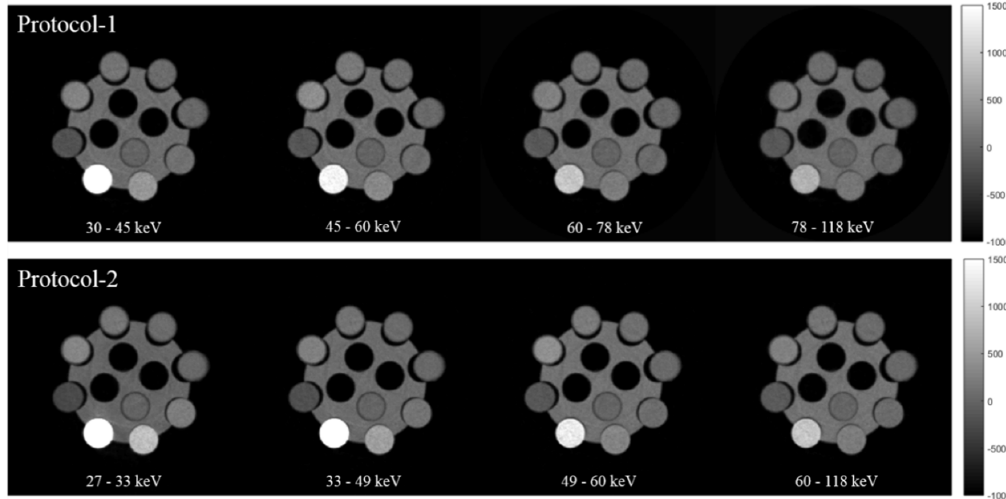
Figure 5. Transverse CT slices of Gd/HA with protocol ‐ 1 (top row images) and protocol ‐ 2 (bottom images) with 4 energy bins acquired at 118 kVp tube voltage. The grayscale map represents spectroscopic HU ranging from − 1000 to 1500.